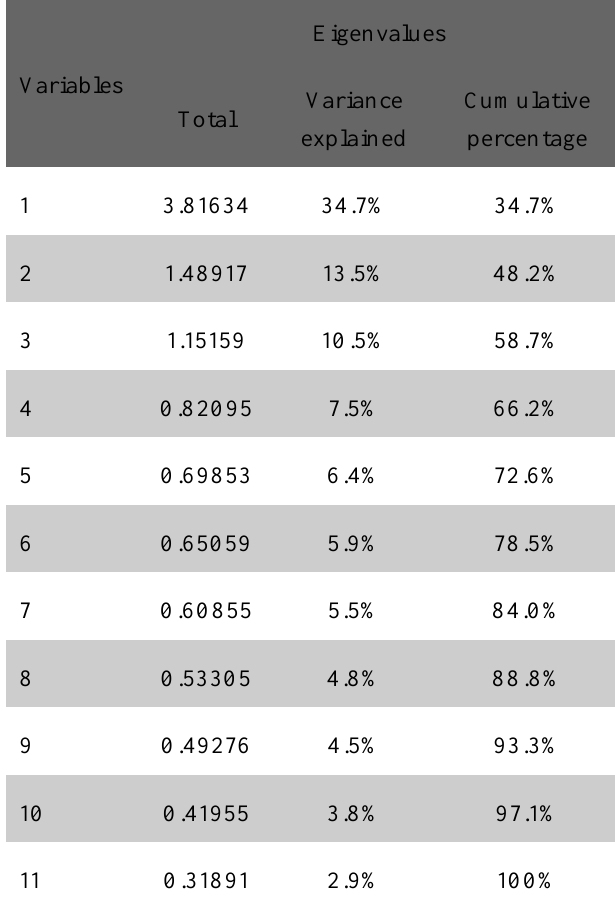
Results for the Extraction of Component Factors